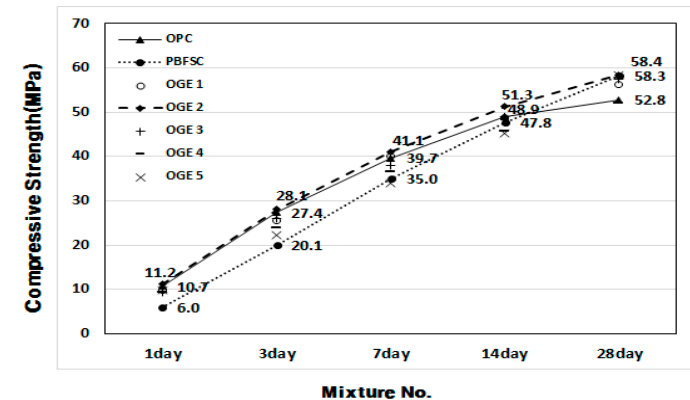
Figure 6. Compressive strength of OGE (MPa) at different aging times and different ESA burning temperatures. Materials 2017 , 10 , 1050